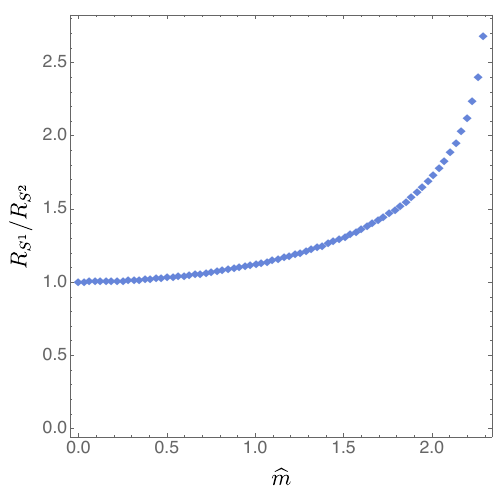
Figure 11 . The ratio of the maximum of the S 1 (located at x = 1 in our coordinates) and the maximum radius of the S 2 (located at x = 0 in our coordinates) at the horizon as a function of